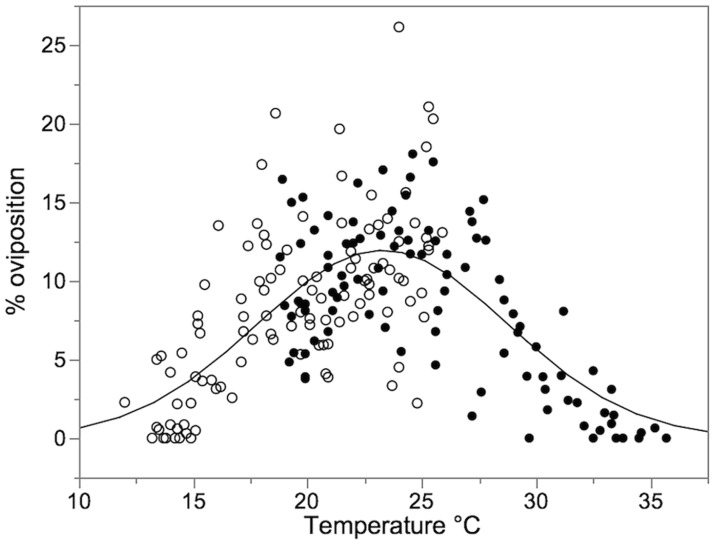
Temperature-dependent oviposition rates of D. suzukii-females on a 12–26°C gradient (open symbols) and on a 18–36°C gradient (closed symbols).The line represents the calculated Gaussian distribution (h × exp[(−temperature − x0)2 ÷ (2 × w2)]; for h = 11.937; x0 = 23.28; w = 5.486; N = 204; RMSE = 3.798; alpha = 0.05; convergence criterion: 0.00001).